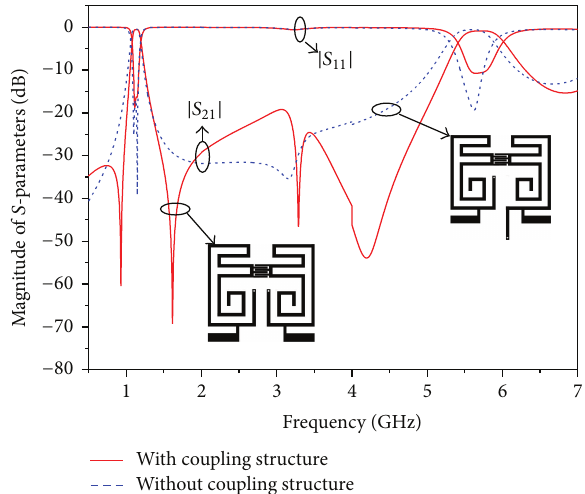
Figure 5: Response of proposed bandpass filter of different